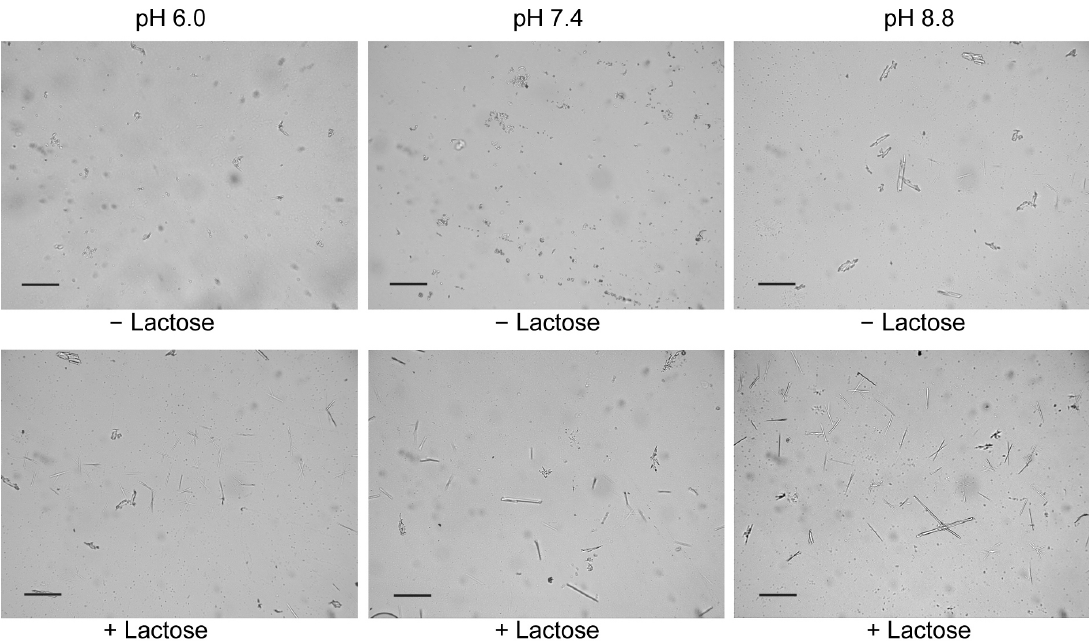
Figure 4. Effects of pH on Gal-10 crystallization. Gal-10 was diluted to 10 µ M in PBS–azide buffer at pH 8.8, 7.4, and 6.0, with 0.01% Coomassie brilliant blue R-250 and incubated with or without 1 mM lactose for 24 h. The crystals were observed under a light microscope. Bar = 50 µ